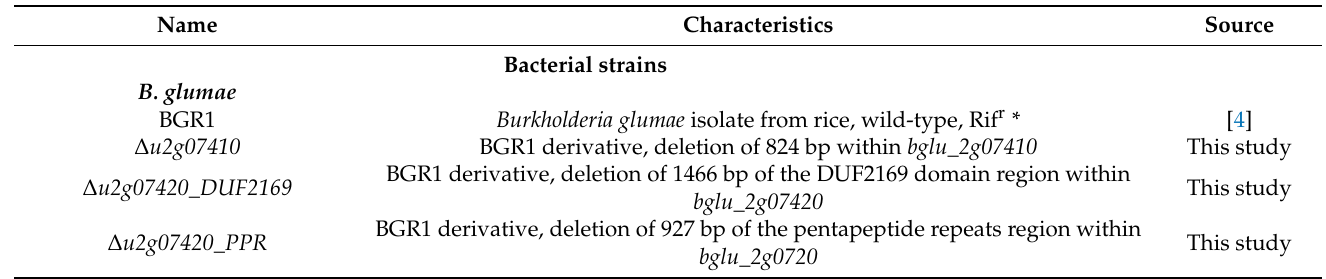
Table 2. Bacterial strains and plasmids used in this